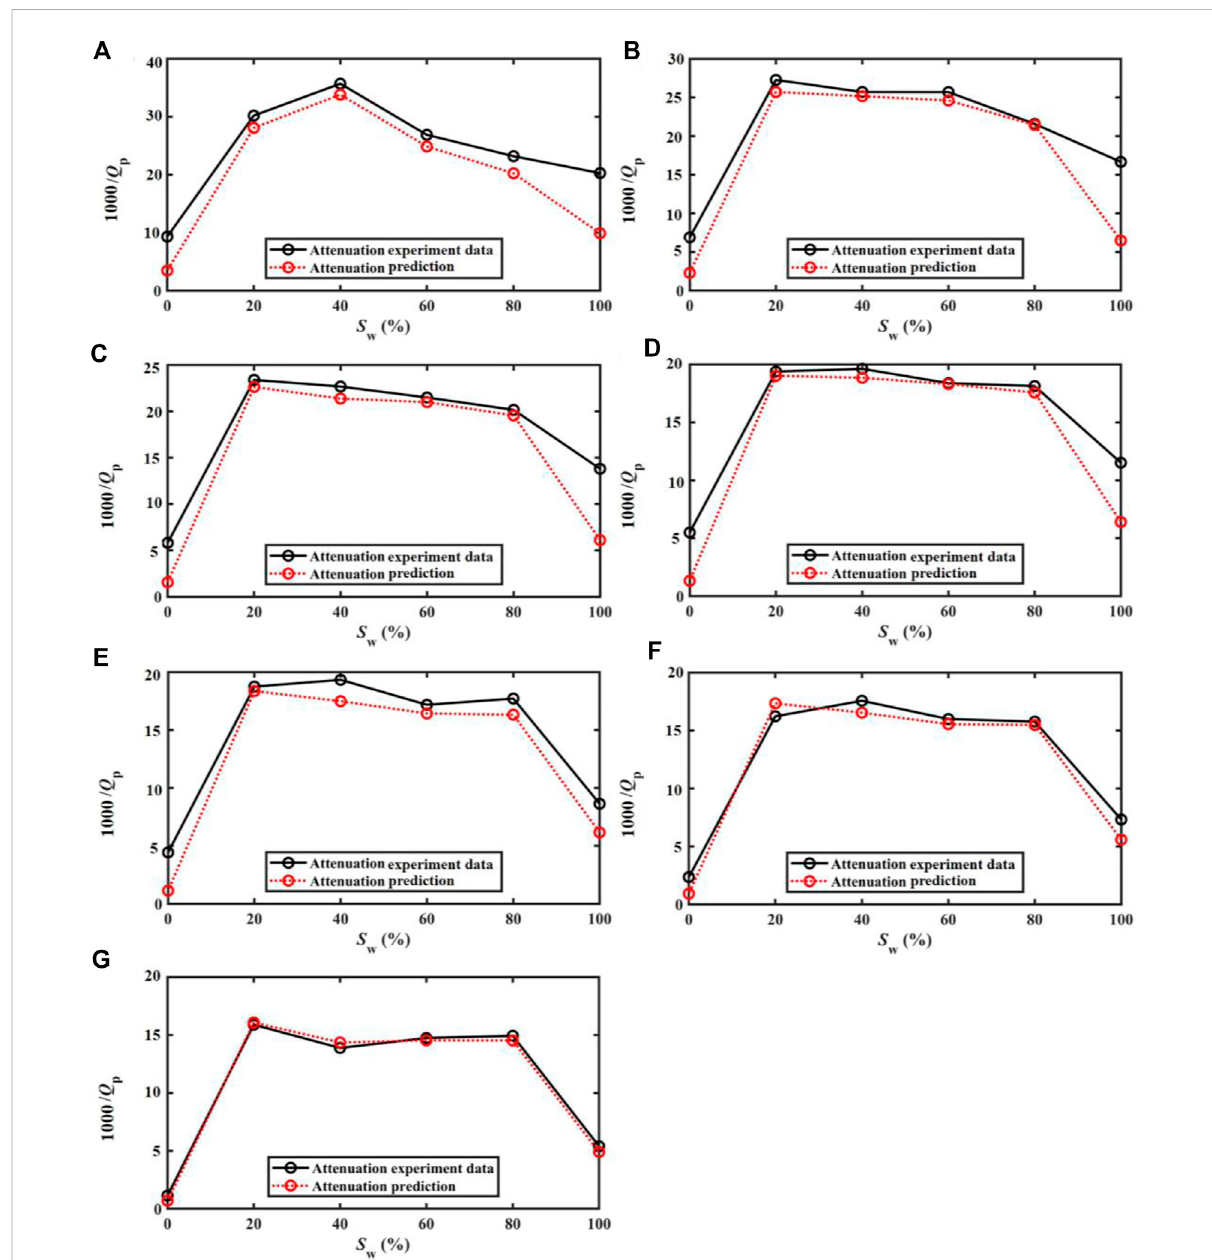
FIGURE 13 P-wavedissipationfactorasafunctionofwatersaturationcomparedtotheexperimentaldataforsample1 – 19at5 MPa (A) ,10 MPa (B) ,20